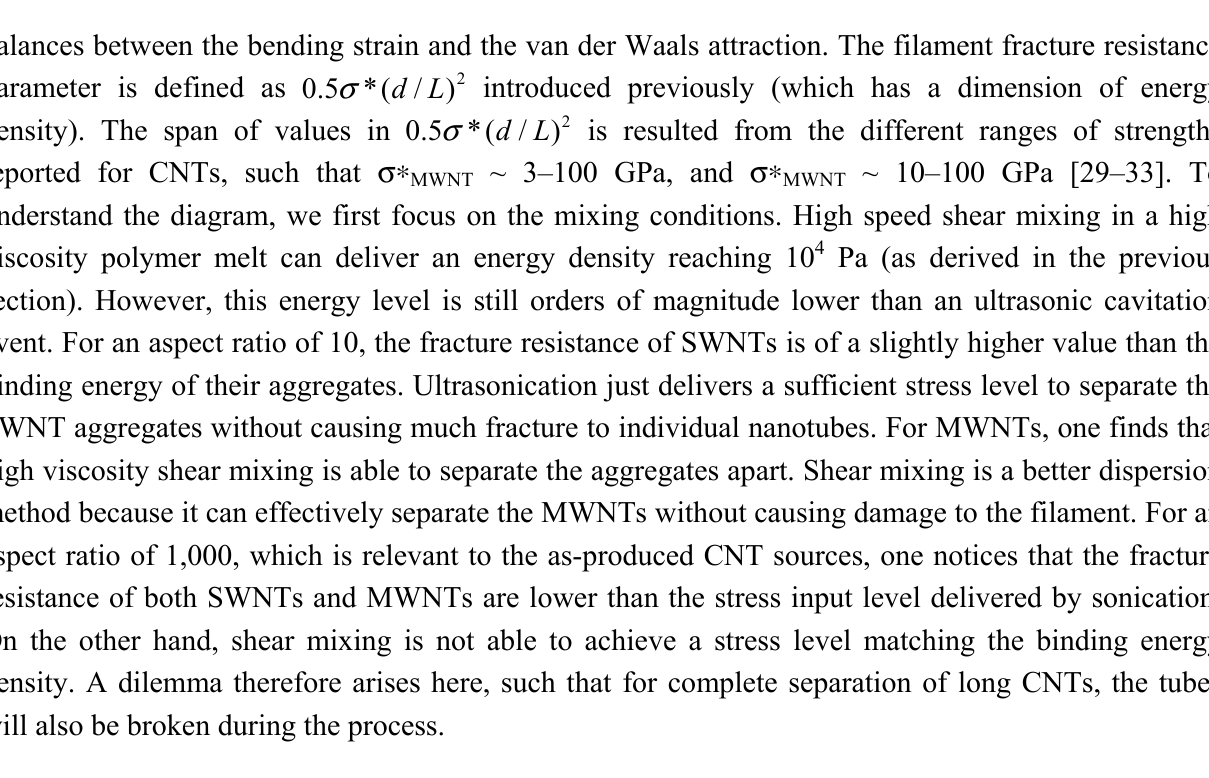
Figure 4. An energy diagram showing the theoretical capabilities and limitations of shear-mixing and ultrasonication for carbon nanotube (CNT) dispersion, using filament aspect ratios L = d of 10 and 1,000 as